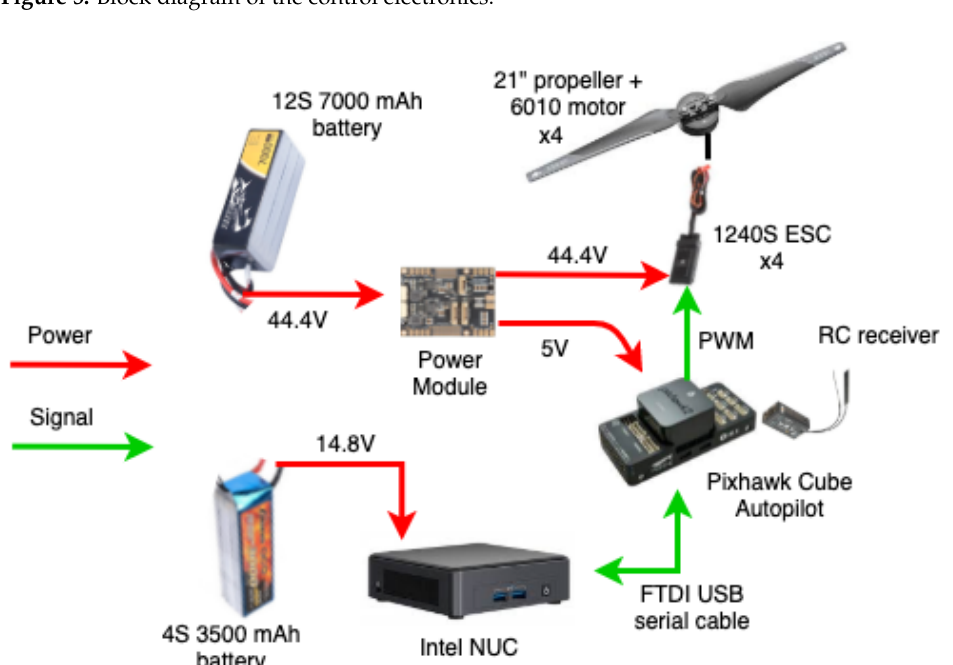
Figure 6. The details of the electronics and voltages of the units.